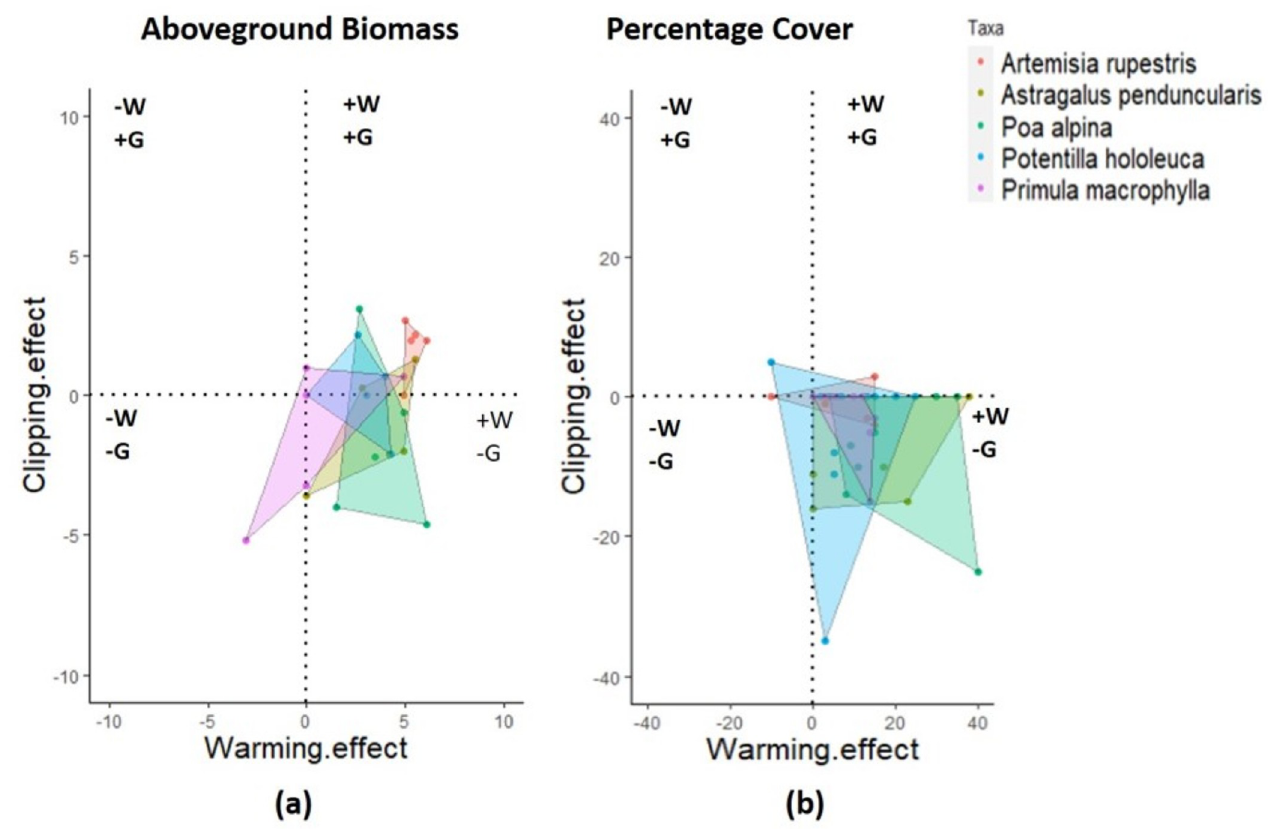
Fig 4. Susceptibility zones of the five most frequent and culturally important plant species under combined impacts of warming (w) and clipping (g) treatments a) warming and clipping effect on aboveground biomass of plant species. b) warming and clipping effect on percent cover of plant species. The susceptibility zones were combined positive effects (+W , +G) , combined negative effects (–W , –G) , and antagonistic effects (–W , +G or +W , –G) . Polygons join the dots of the presence of a species in the respective zone. � represent the significant positive impact of warming .